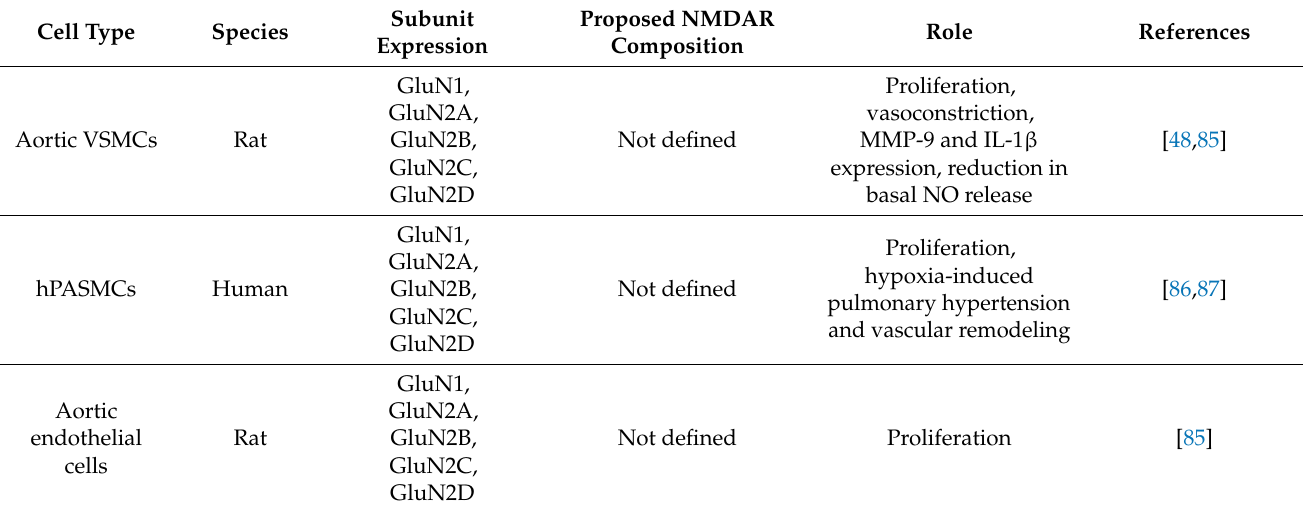
Table 2. NMDARs in the vascular